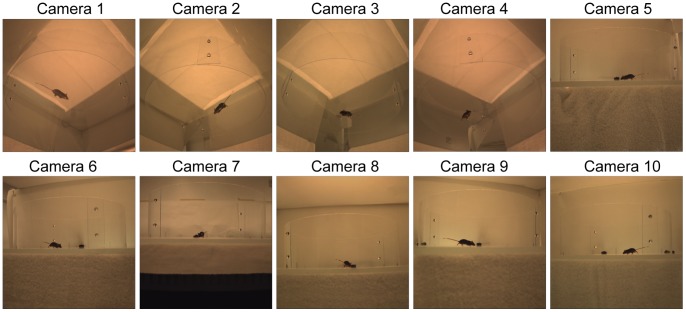
Synchronized images from each of the 10 cameras.Four cameras were positioned under the capture volume (1–4) and six parallel to the floor (5–10) to provide 10 unique silhouettes of the animal at each time.